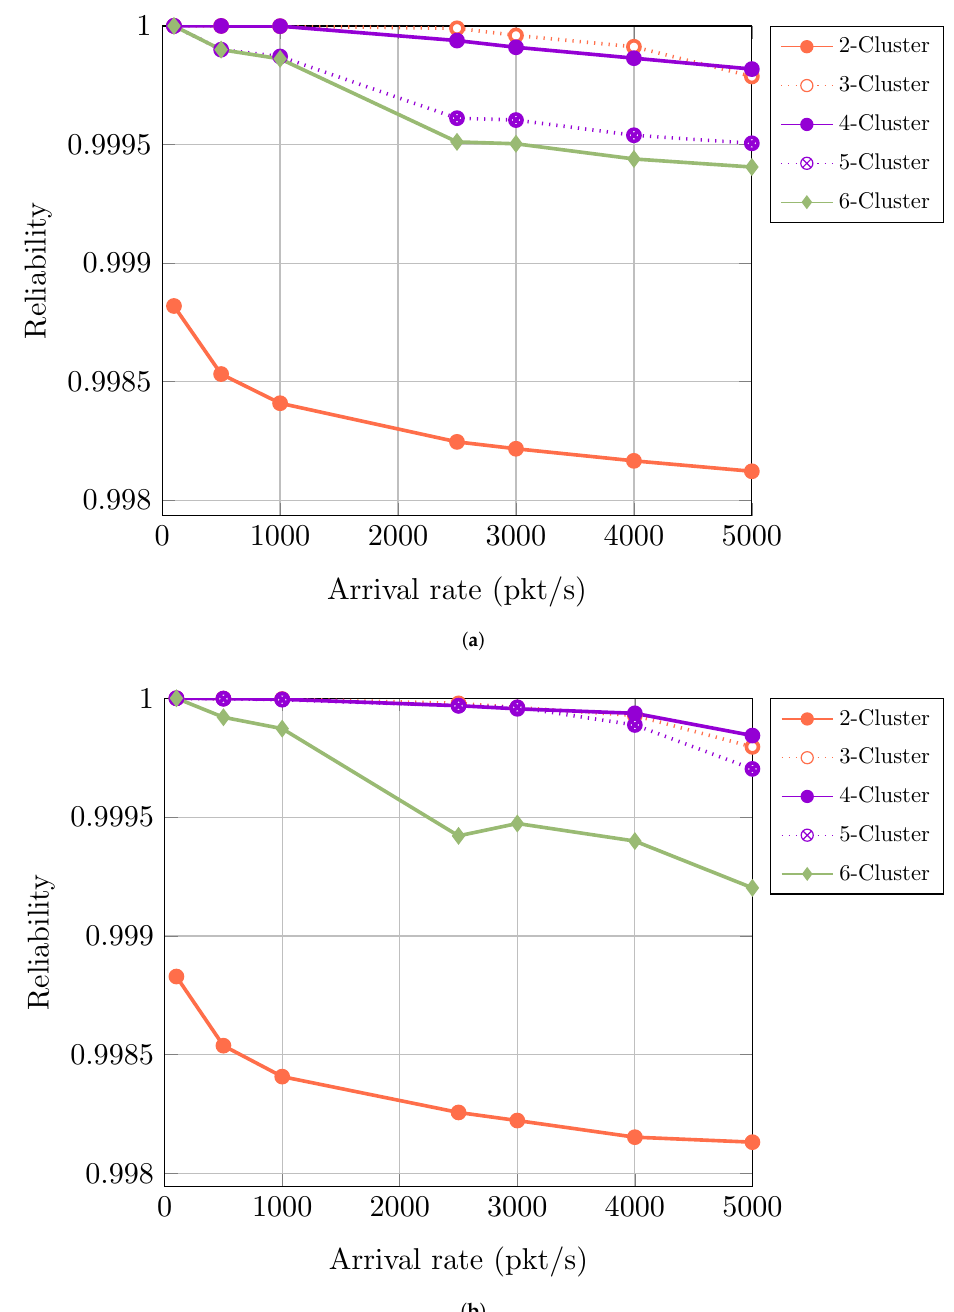
Figure 9. Determine reliability for different clusters using 5-packet duplication. ( a ) Mathematical, ( b )